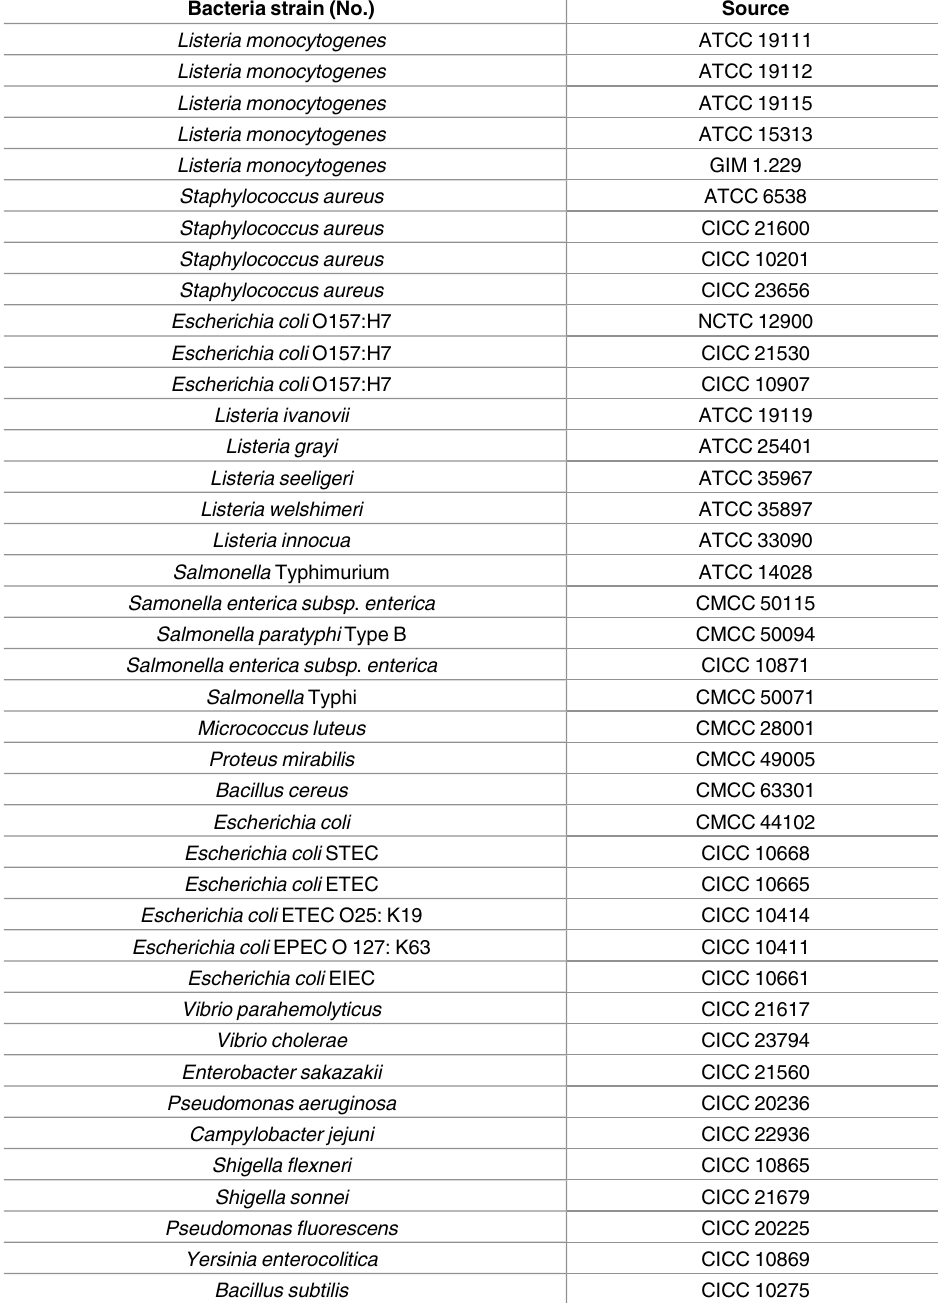
Table 1. List of all bacterial strains used in this